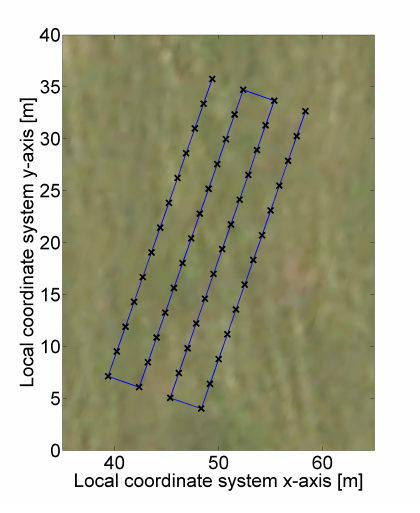
Figure 6: Flight plan.